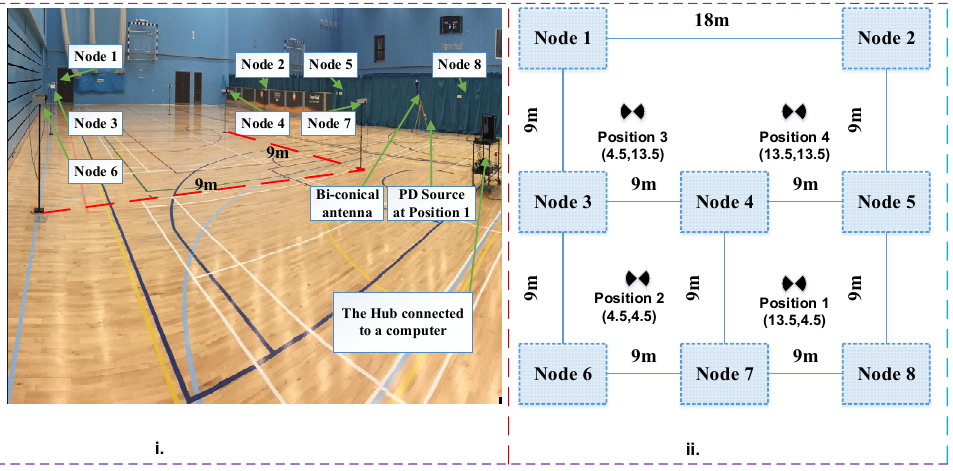
Figure 3. ( i ) Test space image. ( ii ) Sensors arrangement schematic.